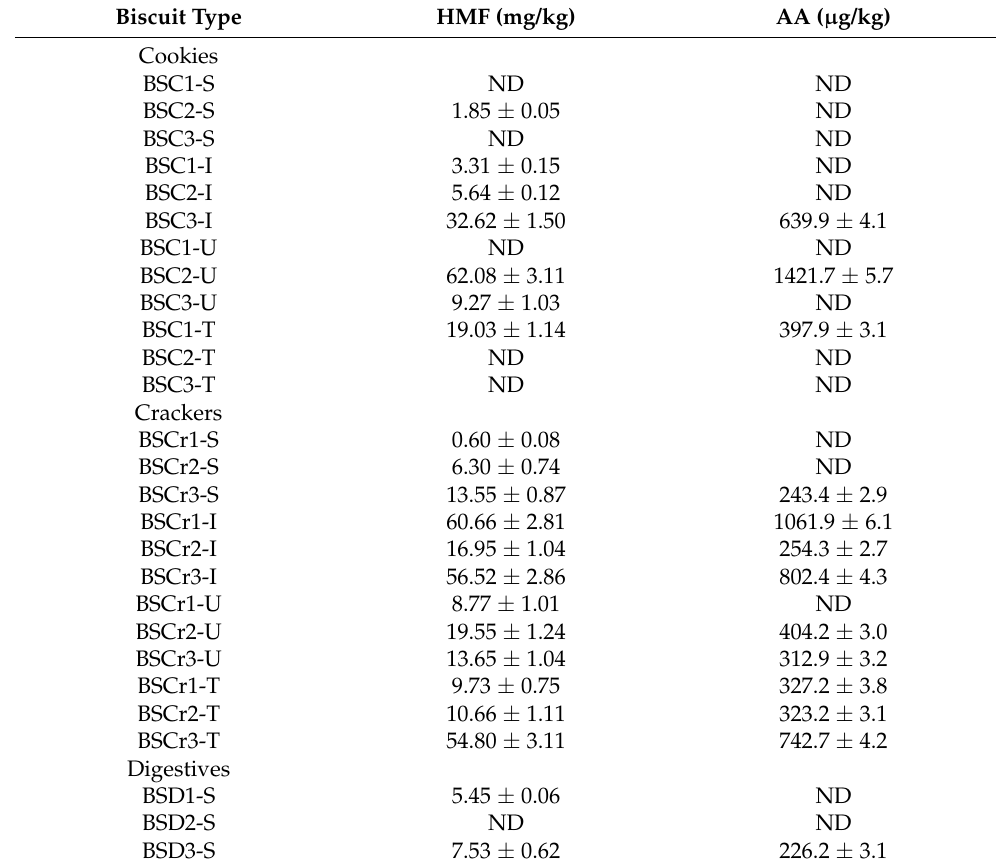
Figure 2. ( a ) HPLC chromatogram of acrylamide standard. ( b ) HPLC chromatogram of acrylamide of a biscuit sample (BSC2-U). Table 3. Content ( µ g/kg) of 5-hydroxymethyl-2-furfural (HMF) and acrylamide (AA) ascertained in biscuits marketed in Basrah,